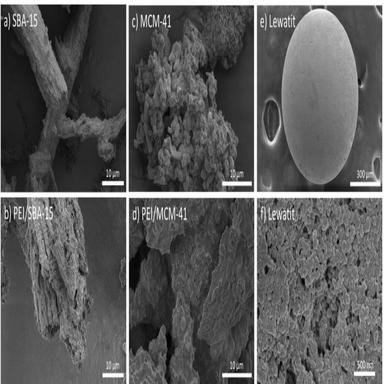
SEM micrographs of (a) pure SBA-15; (b) 800 MW PEI loaded SBA-15; (c) pure MCM-41; (d) 800 MW PEI loaded MCM-41; and (e-f) Lewatit.